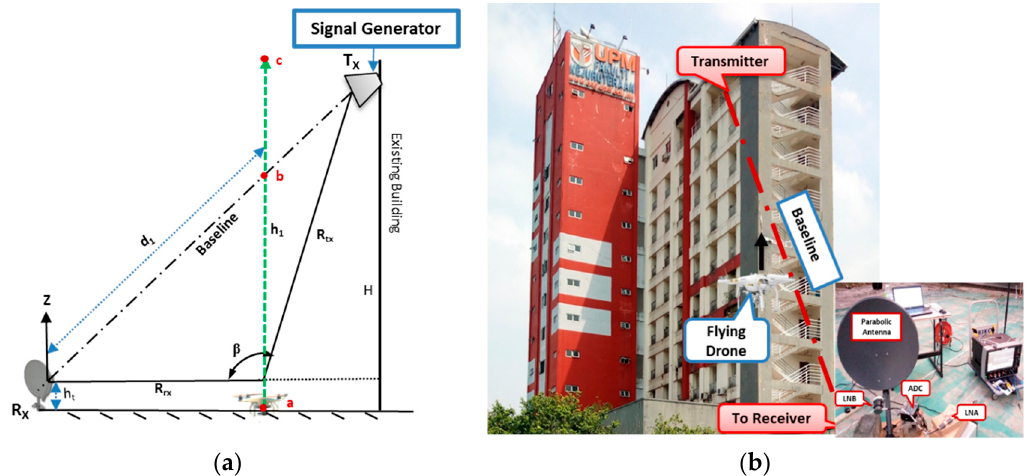
Figure 15. Drone detection experimental setup in ( a ) FSR (Forward Scattering Radar) geometry and ( b ) Site view.